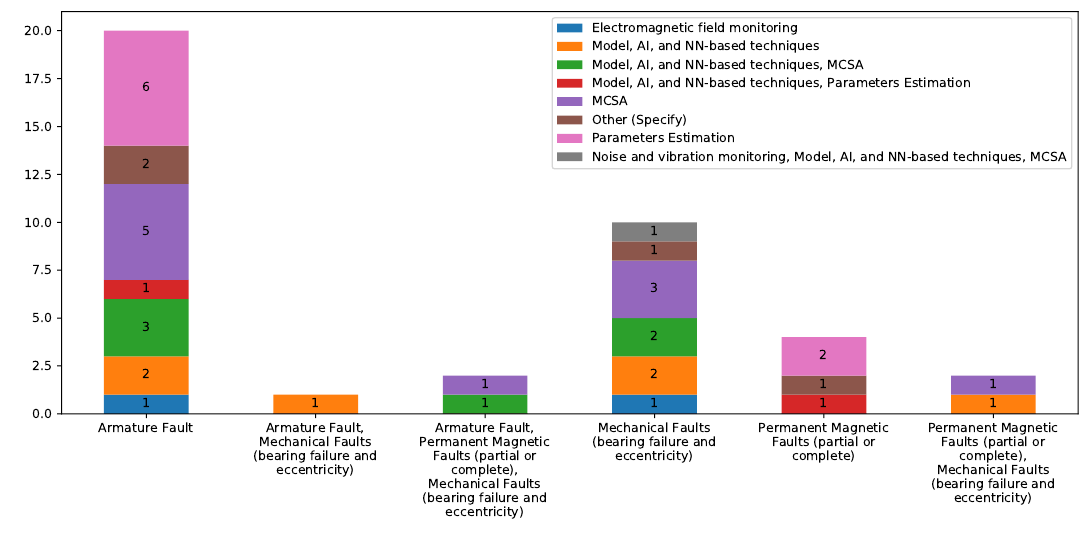
Figure 5. Distribution of the papers according the type of failure and the used